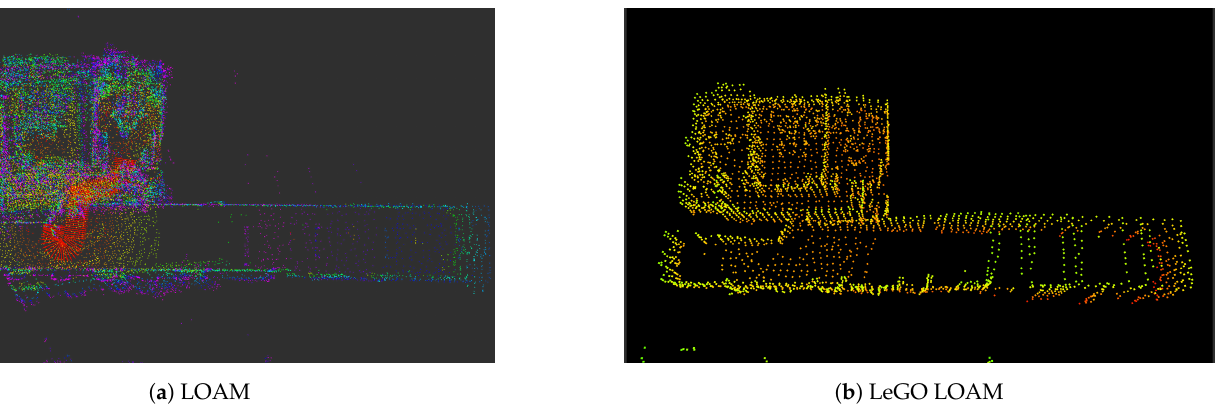
Figure 5. Resulting maps for 3D SLAM algorithms using Velodyne VLP-16 data from a pre-recorded dataset [62] and default parameter values (see Table 3 for LiDAR specifications). The LiDAR was mounted on a Turtlebot 2 at 60 cm of